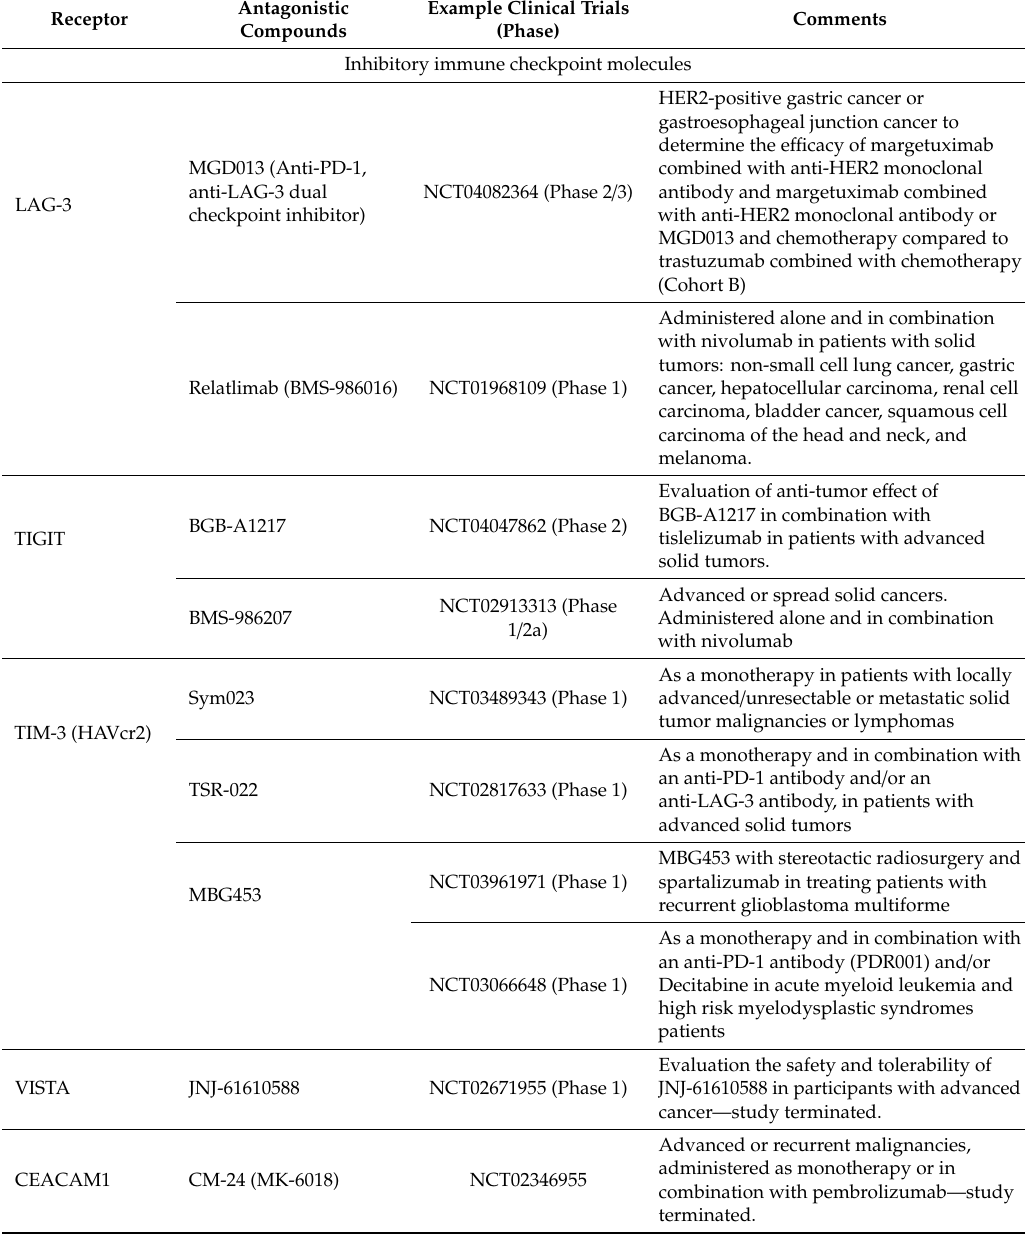
Table 3. Inhibitory and stimulatory immune checkpoint molecules with respective anti-receptor antagonistic antibodies and examples of clinical